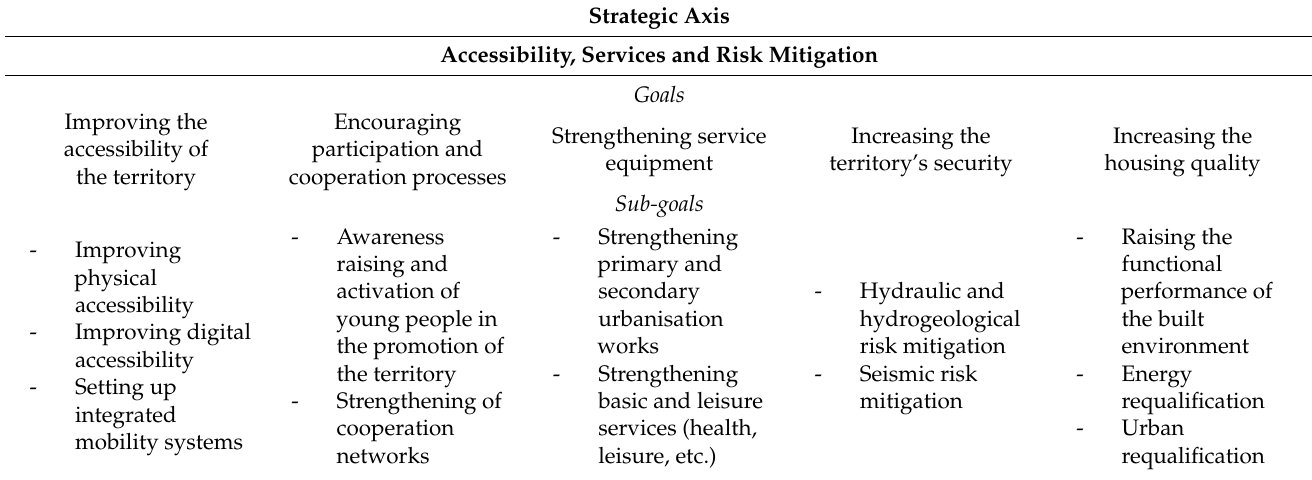
Table 4. Declination of the “Accessibility, services and risk mitigation” strategic axis into goals and sub-goals.